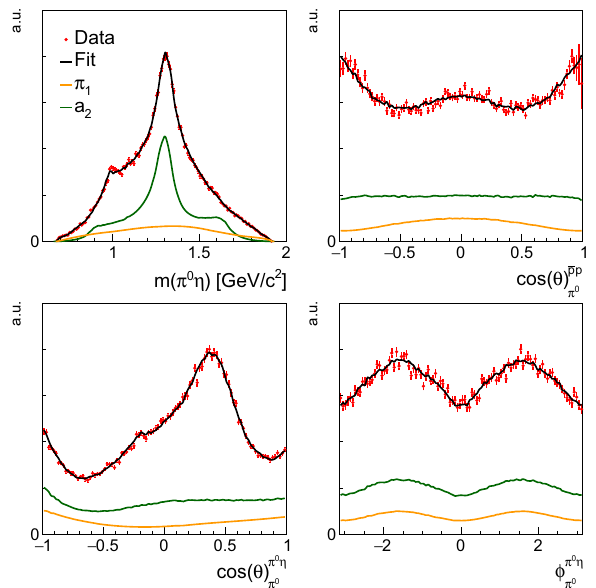
Fig. 1 Invariant mass distribution (upper left) and selected angular distributions for the production (upper right) and decay (lower left and right) of the π 0 π 0 η channel in the ¯ pp data. The red markers with error barsshowtheefficiency-correcteddatawithtwoentriesperevent,while the black curve represents our best fit and the colored curves show the individual contributions of the π 1 - and a 2